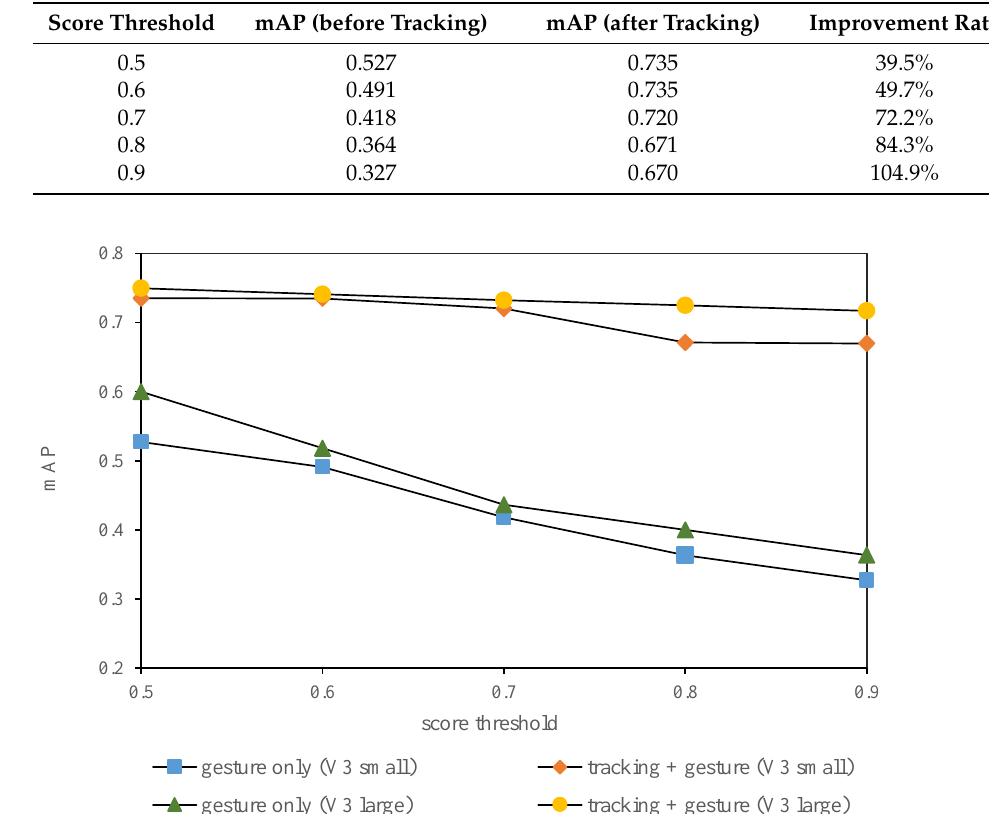
Figure 11. Performance before and after human tracking on the underwater test set. ( a.1 , b.1 , c.1 ) show the results of using only gesture recognition. ( a.2 , b.2 , c.2 ) show the results of adding tracking before gesture recognition. Table 5. Gesture recognition accuracy before and after person tracking with MobileNetV3 Small model.